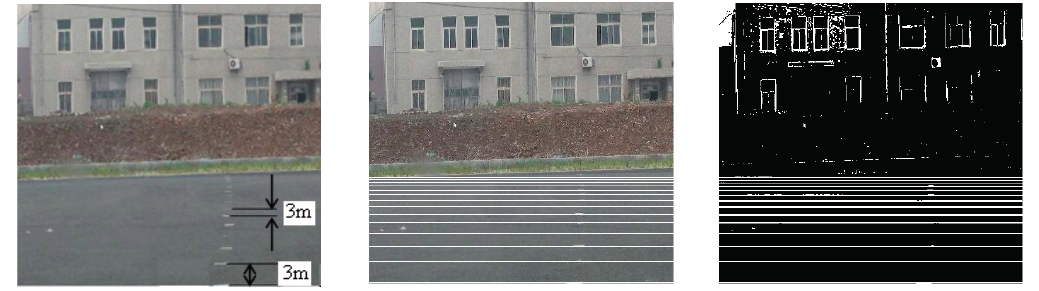
Figure 14. Calibration process of the range estimation model.